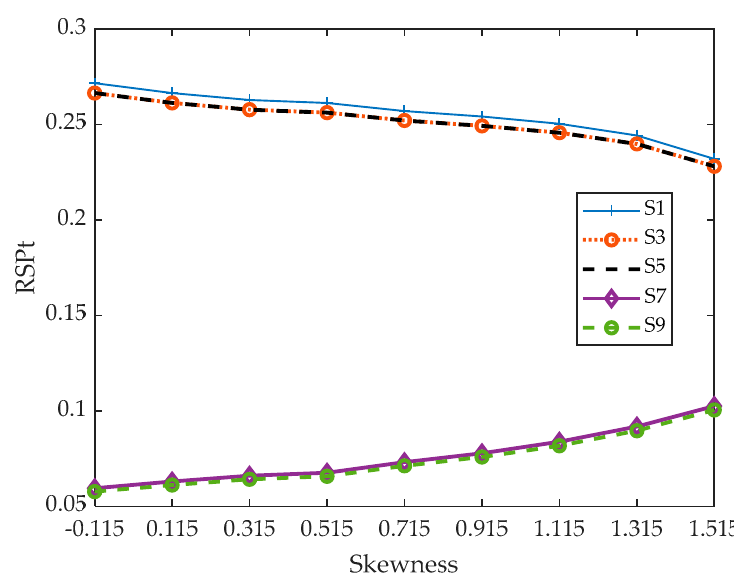
Figure 9. RSP t results for skewness-varying scenarios, i.e., S1, S3, S5, S7, and S9.